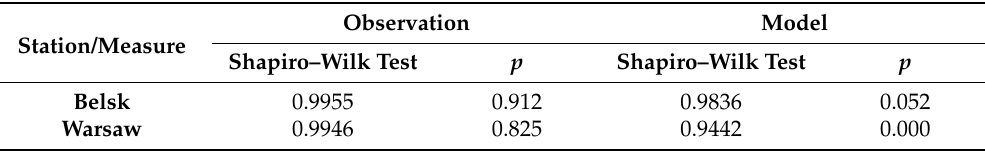
Table 7. Results of the Shapiro–Wilk test together with the right values of probability for Belsk and Warsaw stations for